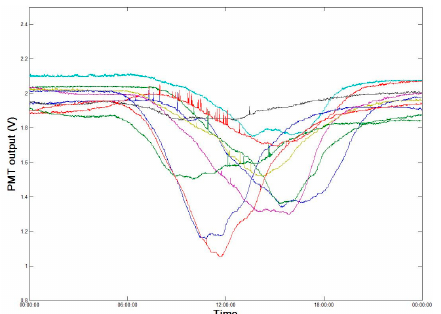
Figure 8. Daily monitoring data using PMT for ten days (each line represents a separate day).